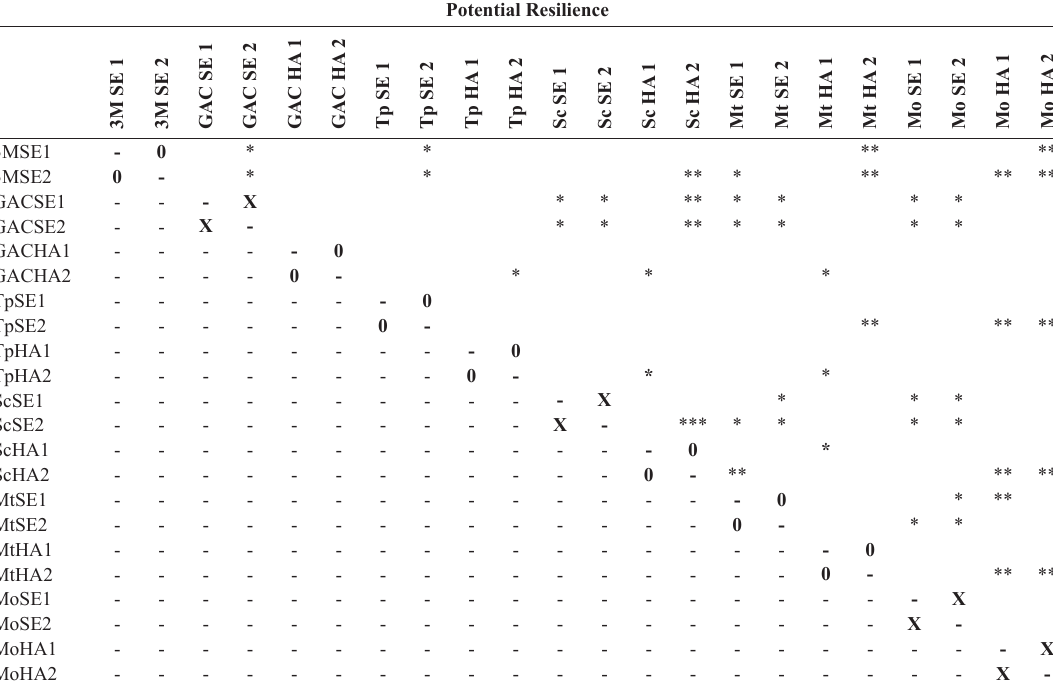
Table 7. Potential resilience comparison among different groups and commercial lots by Tukey test (p=0.05). Potential Resilience